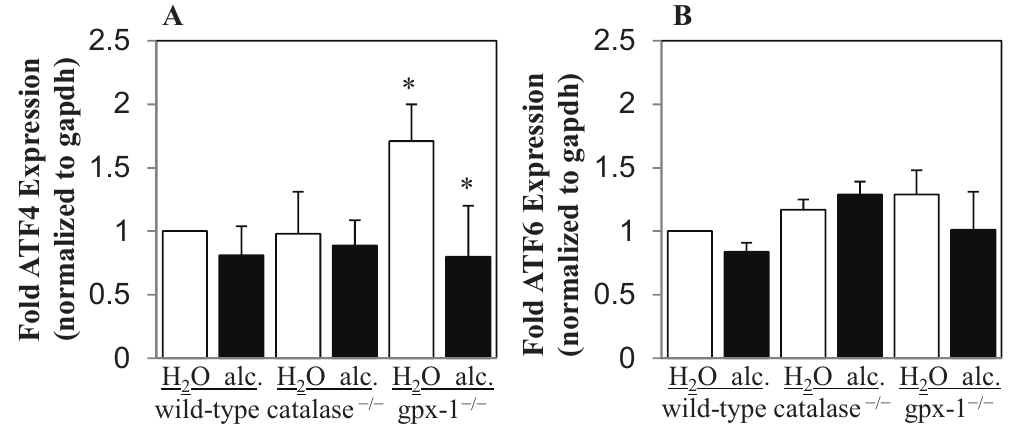
Figure 6. Liver ATF4 and ATF6 mRNA expression. cDNA synthesized from liver RNA of wild-type and catalase (cid:2)/(cid:2) or gpx-1 (cid:2)/(cid:2) transgenic mice, fed with plain water (H 2 O) or ethanol (alc.), was employed to determine ATF4 ( A ) and ATF6 ( B ) mRNA expression by real-time PCR. Gene expression levels in alcohol fed wild-type and untreated or alcohol-fed transgenic mice were expressed as-fold ATF expression of that in wild-type mice fed with water. Asterisks indicate statistical significance ( p < 0.05).